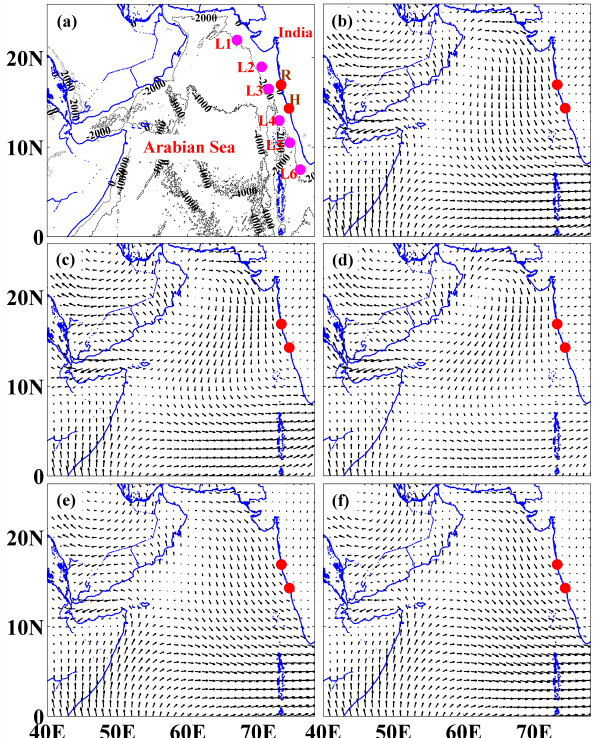
Figure 1. (a) The six locations considered to study the role of DMI on the wave climate are L1 to L6. The wave-measuring locations (Ratnagiri and Honnavar) in central eastern AS are shown as red dots. (b) Composite climatology of wind pattern during October in the AS and part of the equatorial Indian Ocean from 1958 to 2014. Averaged wind pattern during (c) pure positive IOD, (d) combined positive IOD, (e) pure negative IOD and (f) combined negative IOD from 1958 to